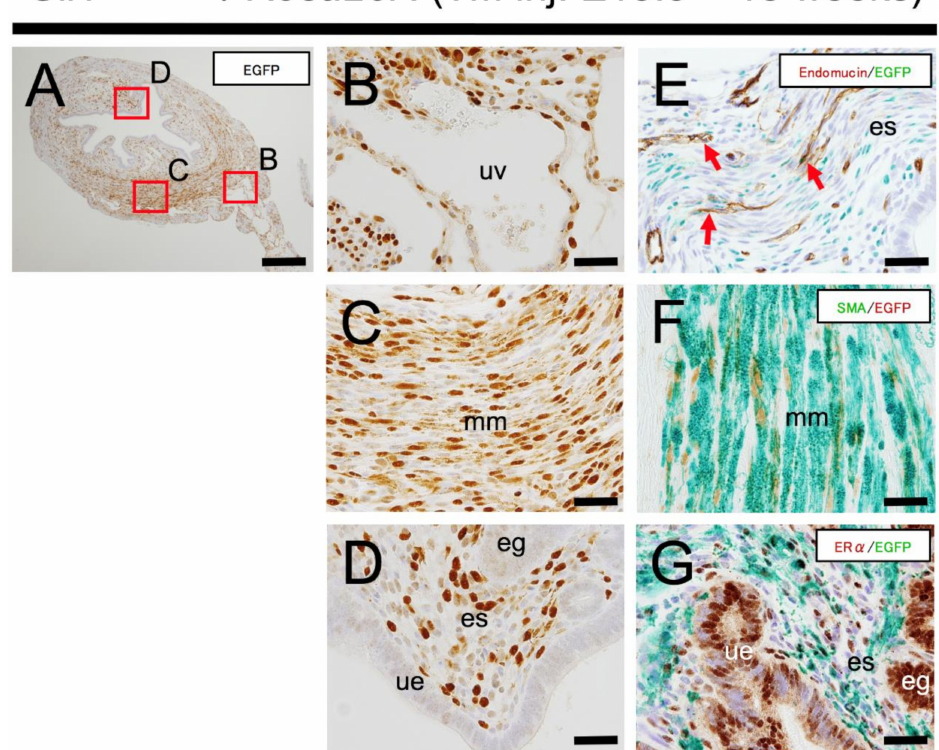
Figure 5. Developmental contribution of Hh-signal-responsive cells in the Wolffian region to adult uterus. ( A – D ) Immuno- histostaining with anti-EGFP Ab of the mouse uterus at 18 weeks of age. EGFP immunoreactivity showing embryonic Hh-signal-responsiveness is observed in the uterine vessel ( B ), myometrium ( C ) and endometrium ( D ). ( E – G ) Double immunohistostaining of EGFP stained with Histogreen plus endomucin, α SMA and ER α stained with DAB. Double immunohistostaining analysis confirms that EGFP positive cells are localized in the uterine vessel ( E ; red arrows), my- ometrium ( F ) and endometrium ( G ). ( B – D ) Higher magnification of red boxes in ( A ). These results were observed in several individuals ( n = 3). ue, uterine epithelium; es, endometrial stroma; e.g., endometrial gland; mm, myometrium; uv, uterine vessel. Scale bars indicate 200 µ m ( A ) and 50 µ m ( B – G